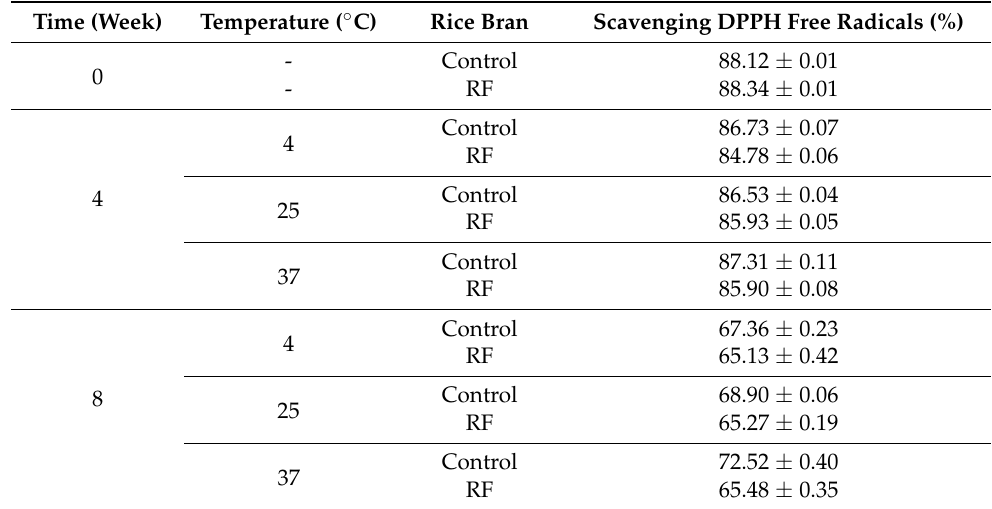
Table 4. Changes in the DPPH free radical scavenging ability of the RF-treated rice bran during different temperature